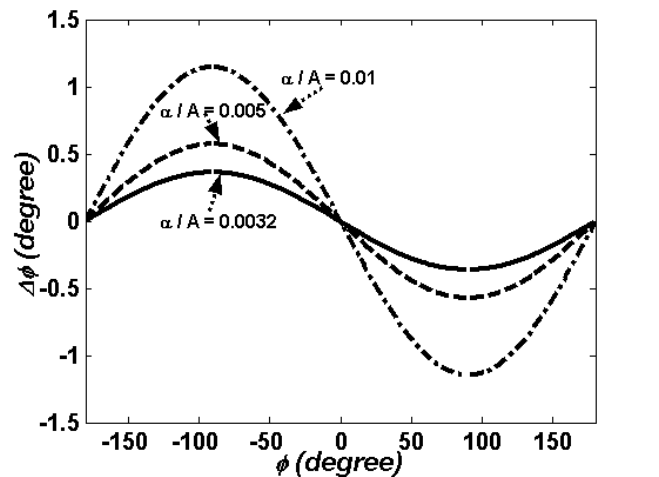
Figure 9. The first order error as a function of the phase difference  .